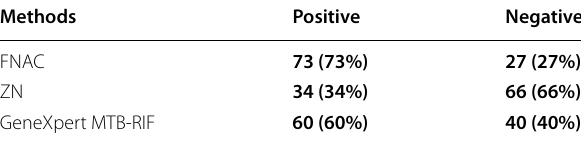
Table 2 TBLN positivity by different diagnostic